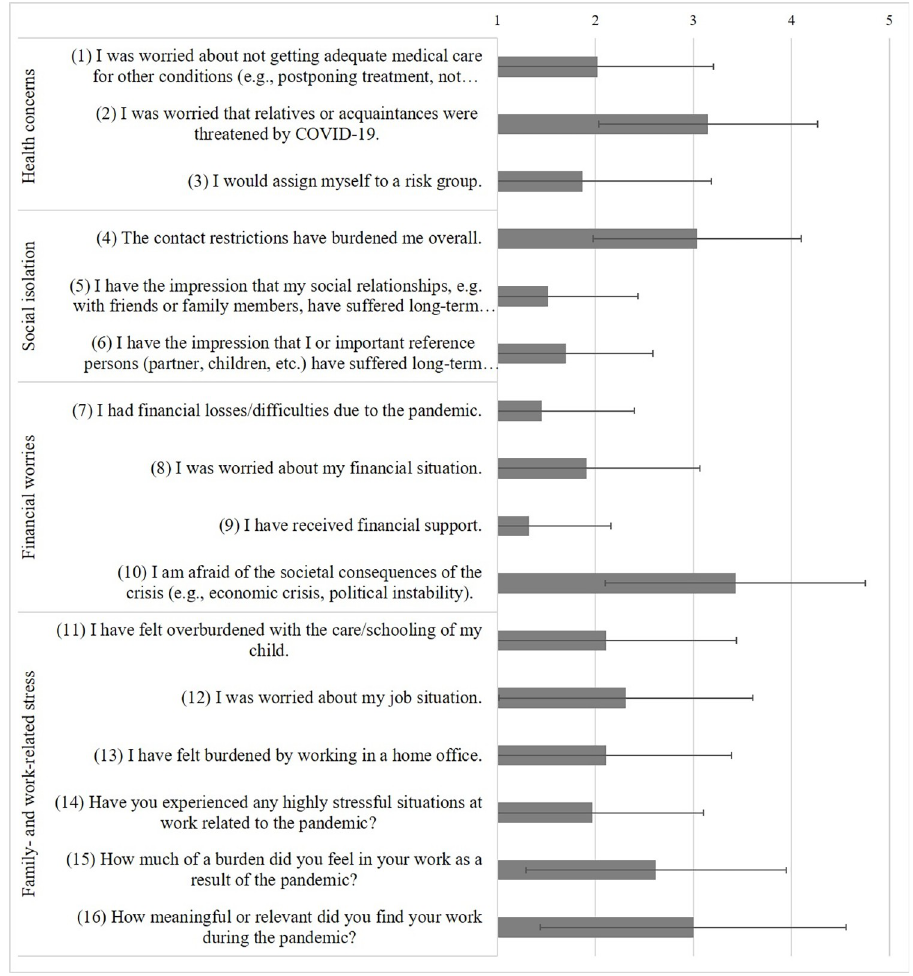
Fig 3. Questions concerning strength of stressors related to the pandemic. Mean and standard deviation of all participants.